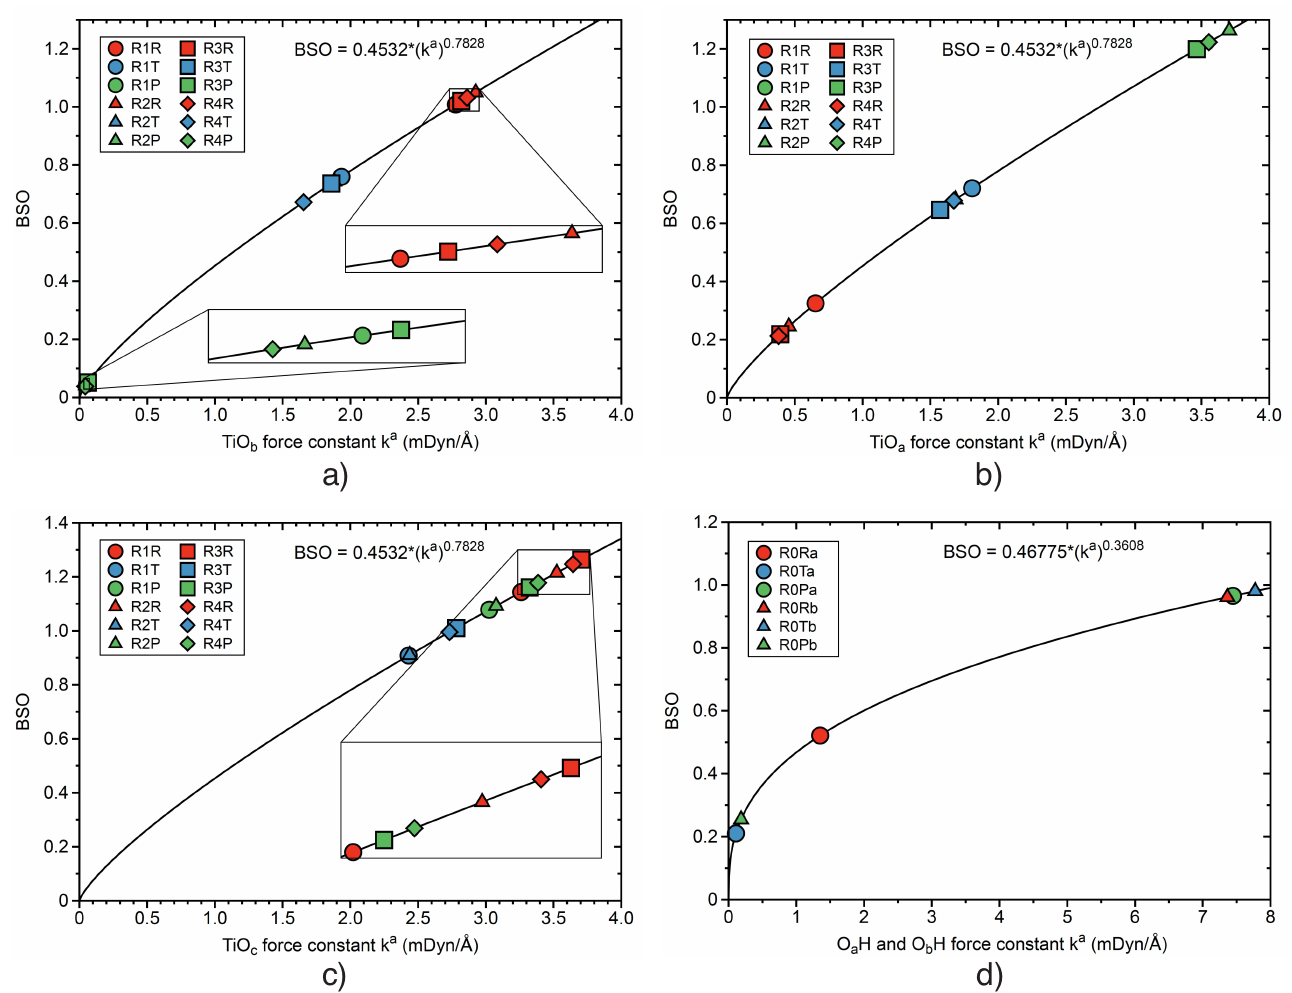
Figure 10. BSO as a function of k a . ( a – c ) TiO b , TiO a and TiO c bonds ( d ) O a H and O b H bonds (for atom d labels see text). RnR, RnT and RnP indicate the reactant (red color), TS (blue color) and product (green color) for reactions Rn , with n=0, · · · 4. B3LYP/6-31G(d,p)/SDD(Ti) level of